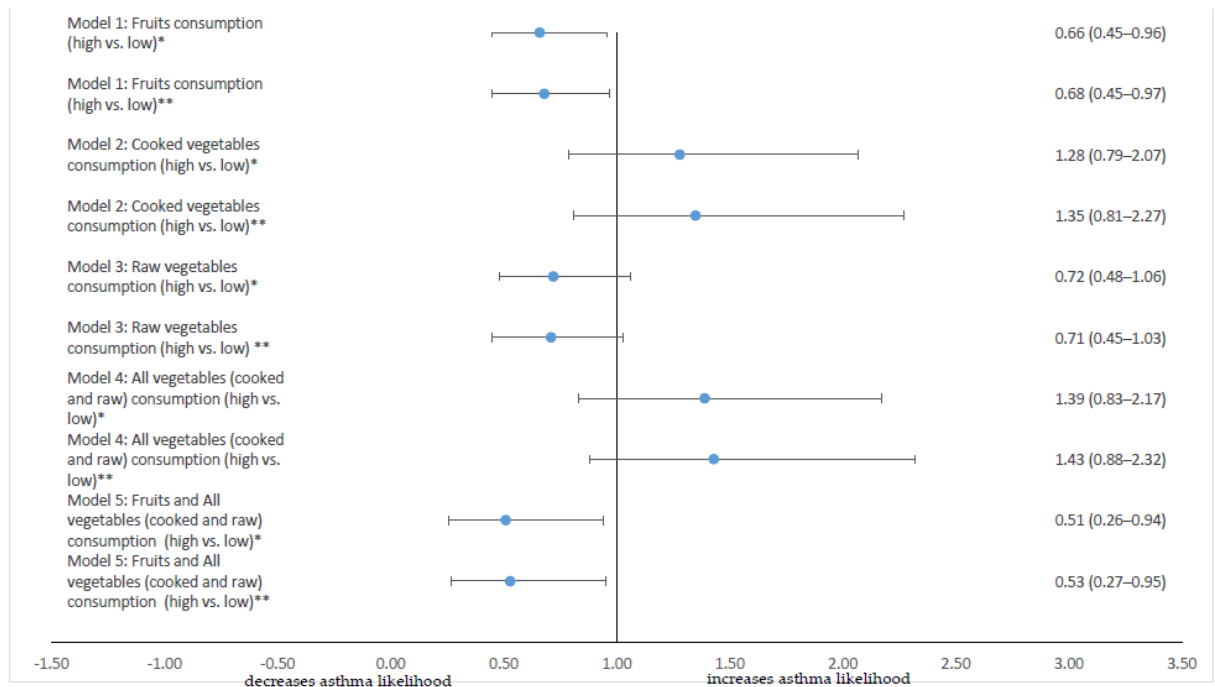
Figure 1. Results from logistic regression analysis (odds ratio (OR), 95% confidence intervals (CI)) assessing the crude and adjusted association of the consumption of fruits (Model 1), cooked vegetables (Model 2), raw vegetables (Model 3), all (cooked and raw) vegetables (Model 4), and fruits and all vegetables (Model 5) on the likelihood of current asthma (defined as having wheezing or whistling in the chest in the past 12 months) on adolescents ( n = 1934). * Crude OR ** adjusted for: adolescents’ sex, body mass index, parental atopic history, parental smoking, pet ownership, having an older sibling, cooking with fuels, indoor exposure to dampness of mold.